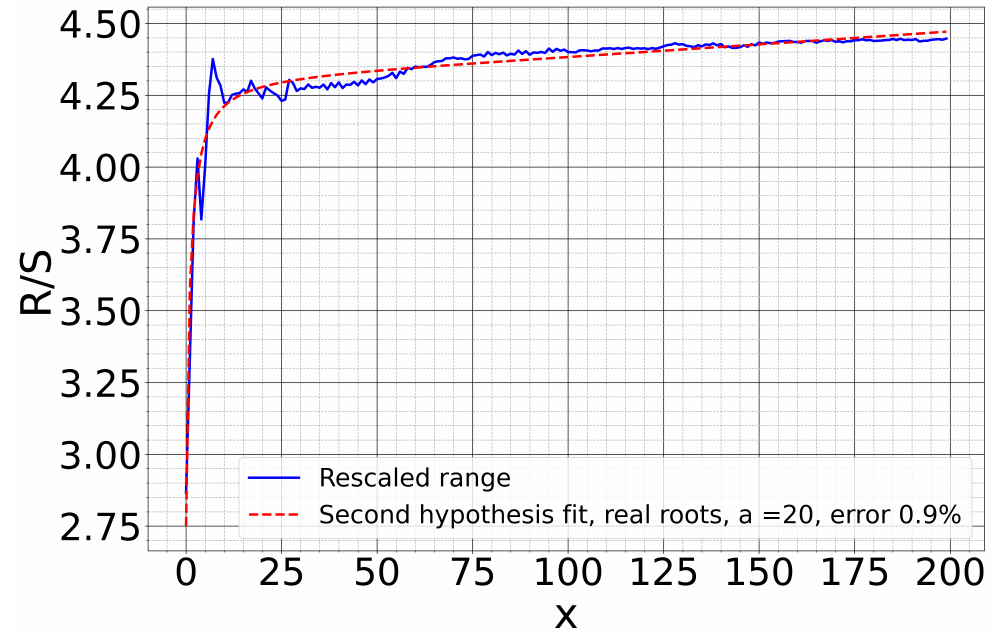
Figure 2. Fitting of NI USRP noise phase R/S (Hypothesis 2): pure real H